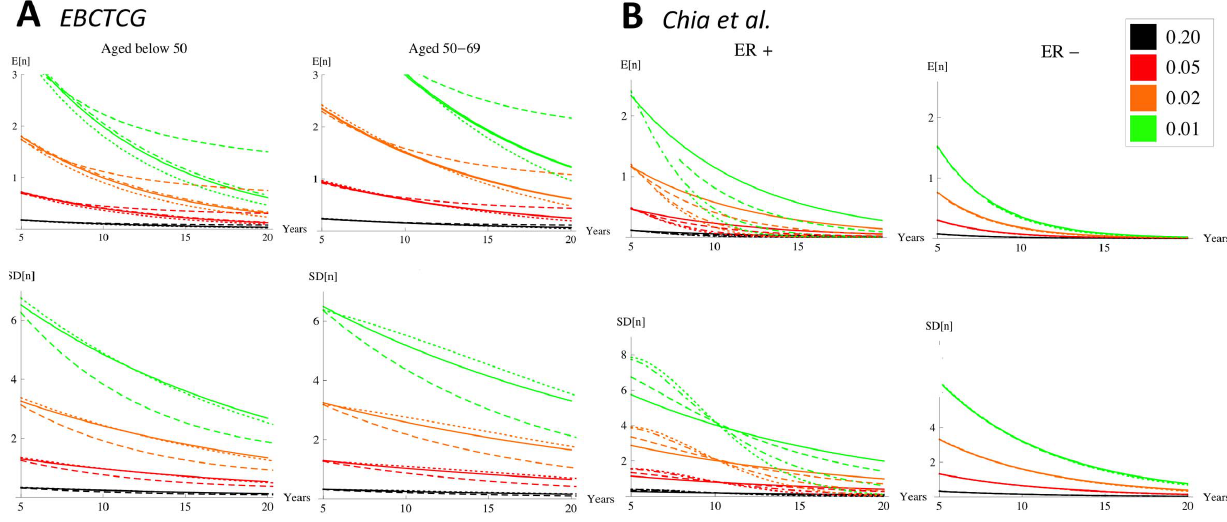
Figure 4. Estimates of means (top row) and standard deviations (bottom row) in patients’ numbers of micrometastases. This is up to 20 years post-resection for different values of k : k ~ 0 : 20 (black), 0 : 05 (red), 0 : 02 (orange), 0 : 01 (green). The graphs use extrapolated hazard rates from Models 0–3 (Figure 2) for the EBCTCG data set (panel A) and the Chia et al. data set (panel B). In each plot, graphs that have solid/dot-dashed/long- dash/short-dash lines correspond to Zeroth Model/Model 1/Model 2/Model